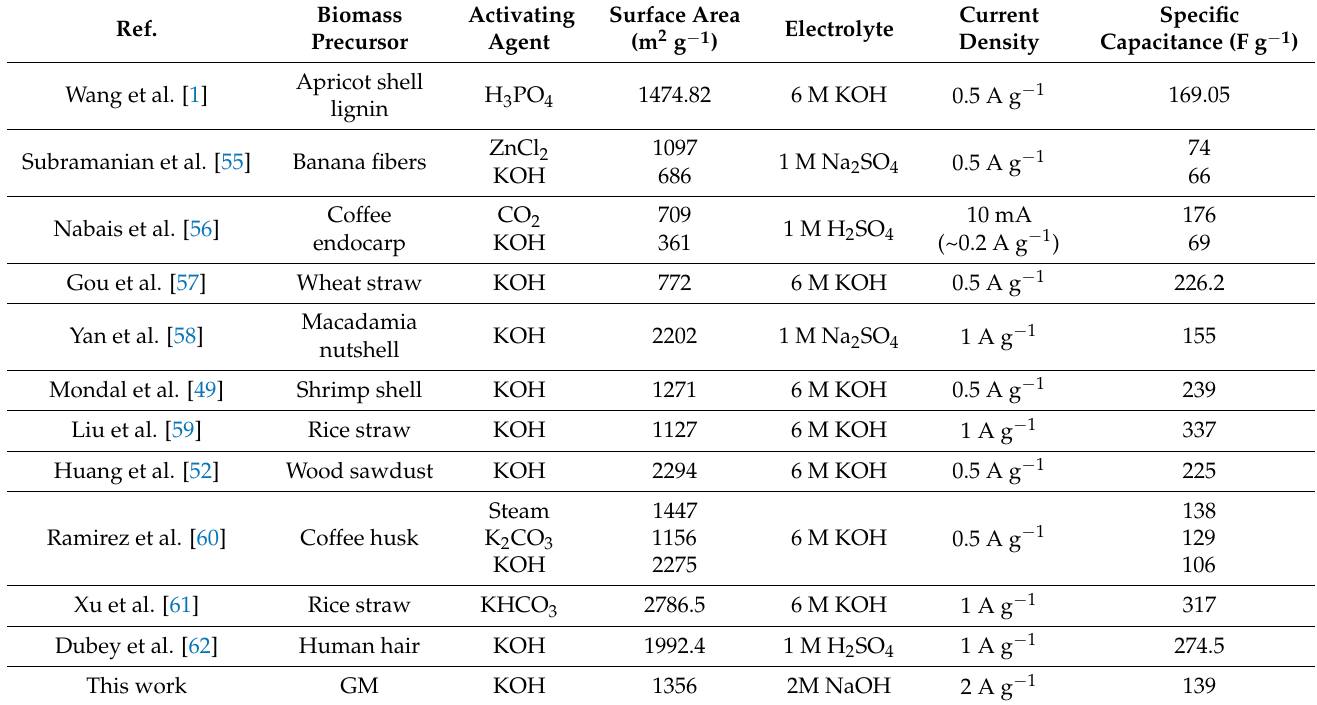
Table 2. Comparison of biomass-based carbon derived from various precursors, with their reported specific capacitances and other relevant